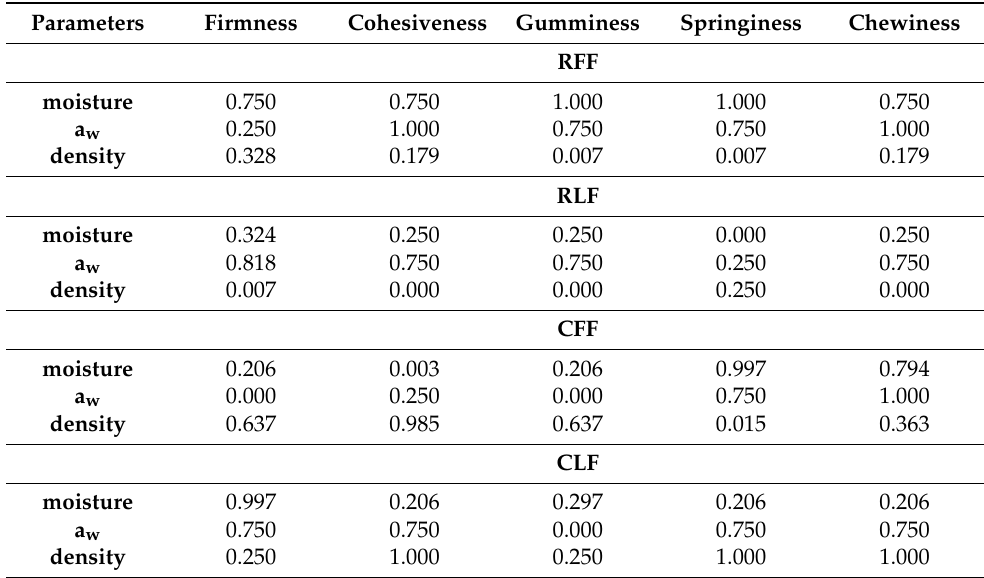
Table 8. Pearson’s correlation coefficients of moisture, a w , density and texture parameters of